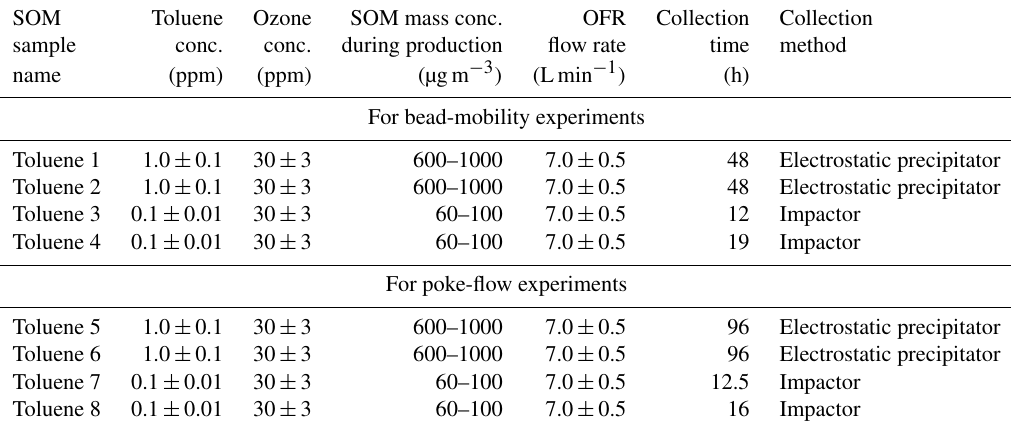
Table 1. Experimental conditions for production and collection of toluene-derived SOM particles using the oxidation flow reactor. Particles were collected onto hydrophobic substrates using an electrostatic precipitator or a single-stage impactor. SOM Toluene Ozone SOM mass conc. OFR Collection Collection sample conc. conc. during production flow rate time method name (ppm) (ppm) (µgm − 3 ) (Lmin − 1 ) (h) For bead-mobility experiments Toluene